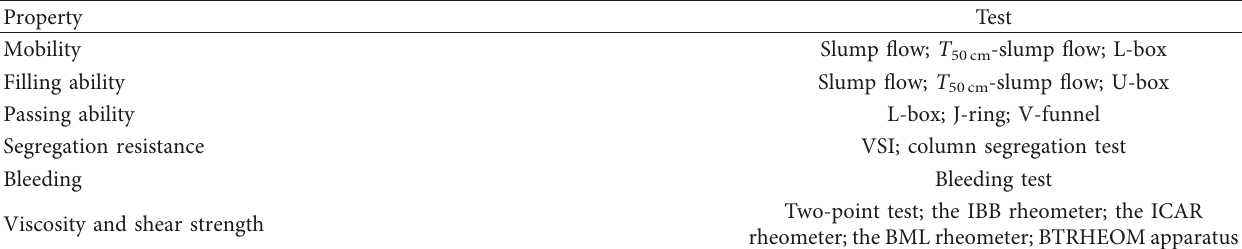
Table 1: Suitable tests for the various properties of SCC.